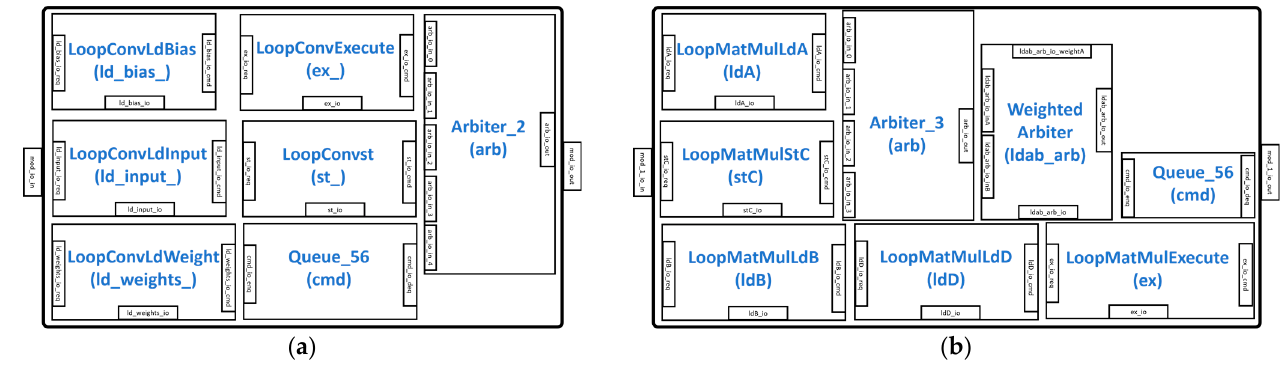
Figure 4. Command unrolling modules: ( a ) LoopConv module; ( b ) LoopMatmul module.